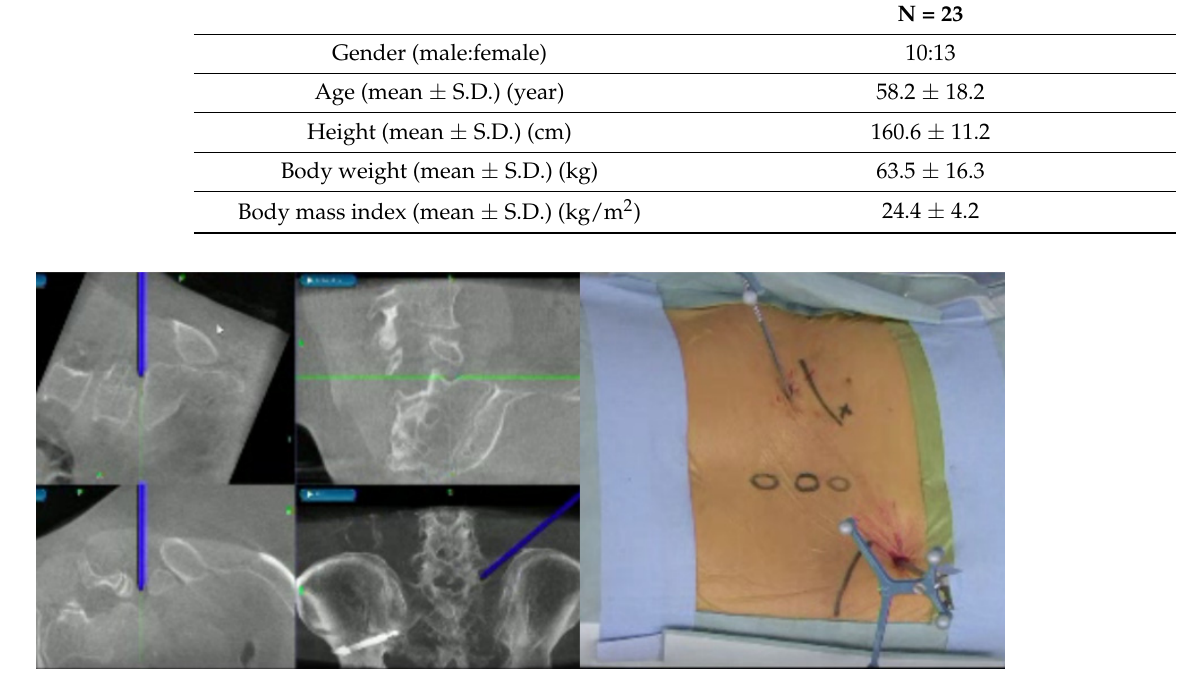
Figure 1. A 57-year-old female. Right L5-S1 lumbar disc herniation. Fully endoscopic discectomy.